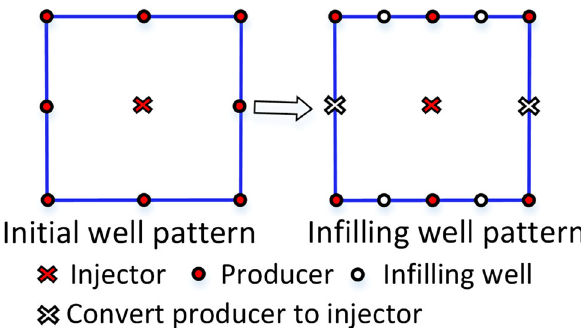
Fig. 4 Sketch of infilling pattern in inverted nine-spot